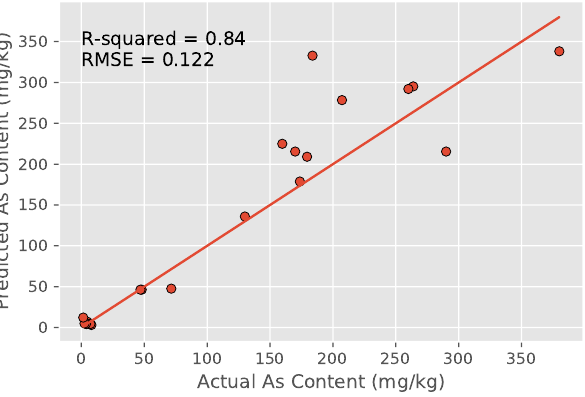
Figure 10. Scatter plot of the soil arsenic concentrations after the use of the DA + GA + SD + RF model with DA-increased dataset, GA-Generated 10 input wavelengths, and SD transformation. The model outperforms all other combinations tested in this study ( R 2 = 0.840 and nRMSE = 0.122). The finalized DA + GA + SD + RF regression model was also comparable to ones